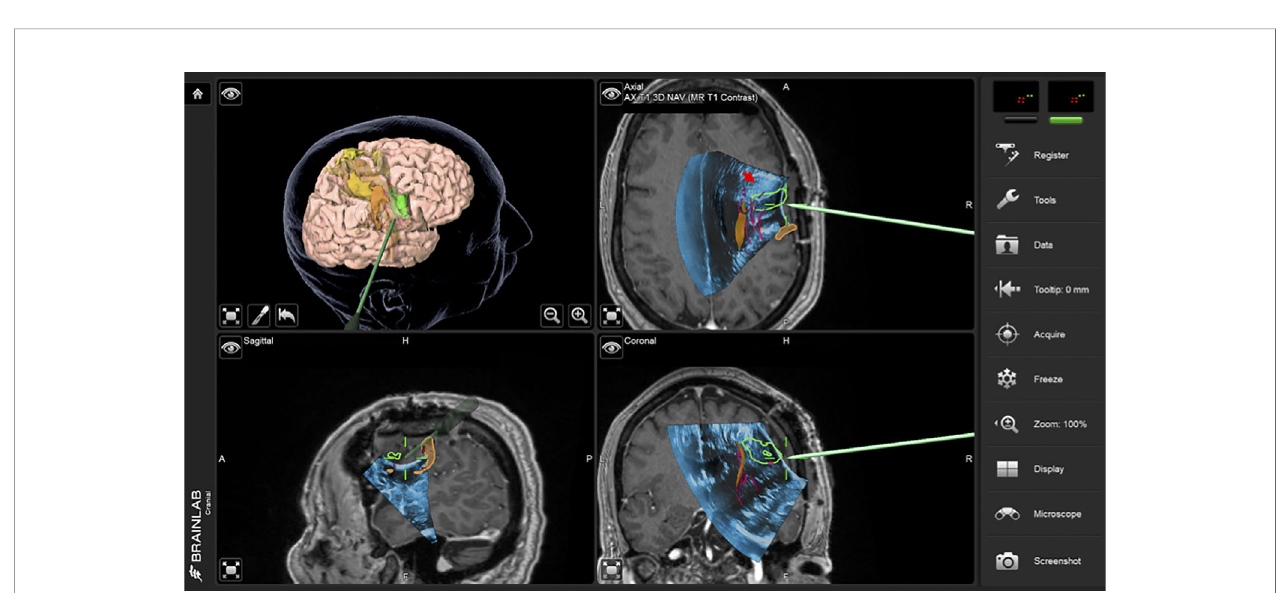
FIGURE 2 | Case 1 intraoperative screen capture with the 3D surgical plan reconstruction with fMRI BOLD activation segmented in orange, tumor in green and Corticospinal Tract in yellow (the upper left panel), and the three orthogonal planes with 3D iUS-1 overlaid on preoperative MP2Rage. Notice the mismatch between the segmented tumor on MRI (green segmentation) and observed tumor on iUS (red arrowhead), placing the tumor site over the sulcus between the gyri making it dif fi cult to know which gyrus was the tumor actually located.